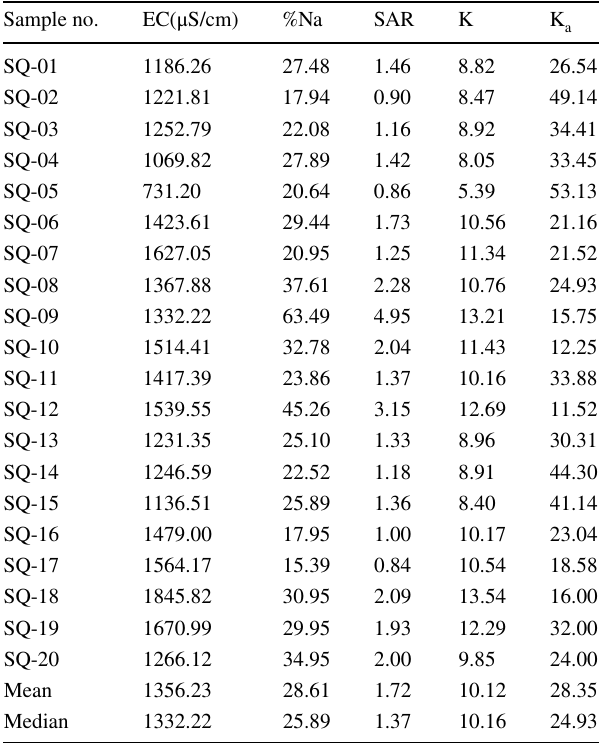
Table 5 Indicators for irrigation water quality assessment Sample